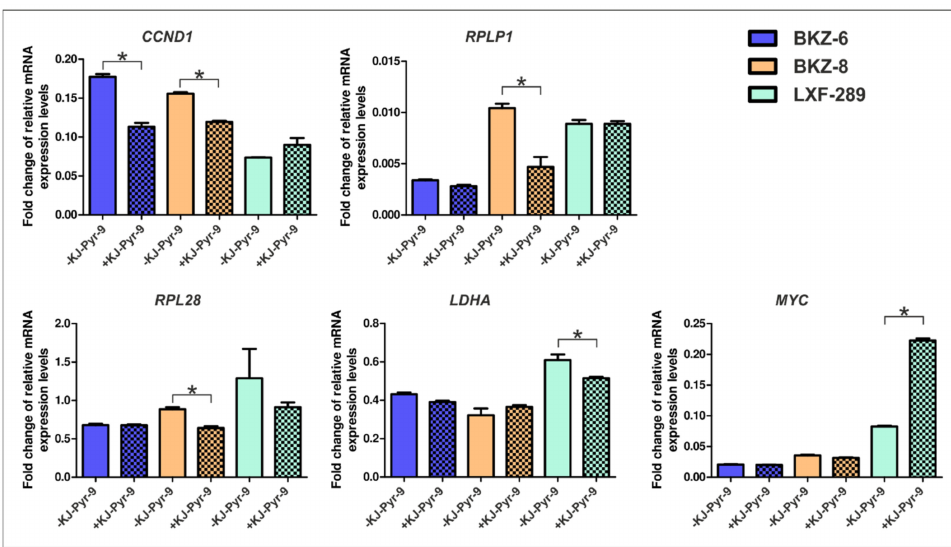
Figure 6. Myc proto-oncogene (MYC)-regulated target genes in lung cancer stem cell (LCSC)-like cells. Quantitative polymerase chain reaction of different target genes of MYC revealed a significant reduction of Cyclin D1 ( CCND1 ) after the application of 20 µ M KJ-Pyr-9 for BKZ-6 and BKZ-8 as representative cell populations for squamous cell carcinoma- and adenocarcinoma-derived LCSC-like cells. Further, BKZ-8 exhibited significantly reduced mRNA expressions of ribosomal protein lateral stalk subunit P1 ( RPLP1 ) and ribosomal protein L28 ( RPL28 ). Additionally, lung adenocarcinoma cell line LXF-289 showed a significantly decreased mRNA level of lactate dehydrogenase A ( LDHA ) and a significantly increase in MYC expression after KJ-Pyr-9 treatment. Non-parametric Mann–Whitney- test ( p ≤ 0.05). n = 3, * p ≤ 0.05. Mean ± SEM (standard error of the